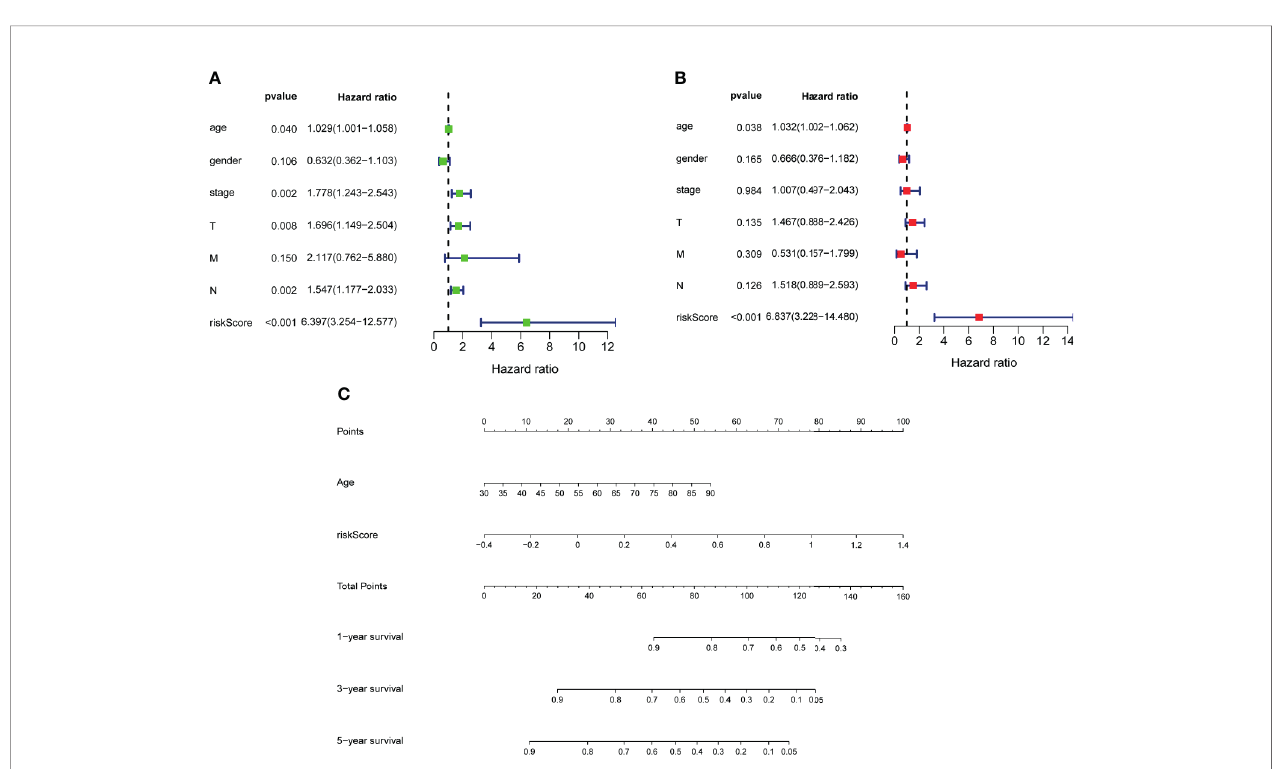
FIGURE 6 | Establishment of nomogram. Univariate (A) and multivariate (B) analyses assessing relationship between risk scores and relevant clinical parameters and OS in TCGA – BLCA cohort. (C) Establishing of a signature-based prognostic nomogram predicting OS in BLCA. OS, overall survival; TCGA, The Cancer Genome Atlas; BLCA, bladder